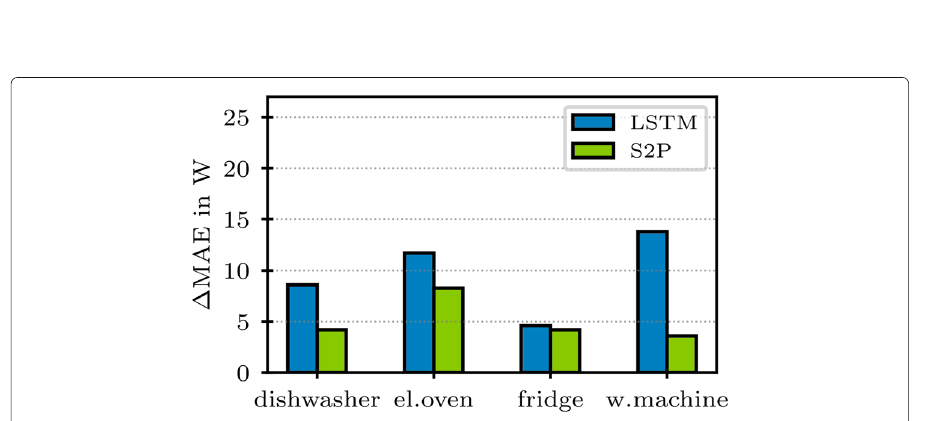
Fig. 4 Performance gap with regard to MAE for UK-DALE house 5